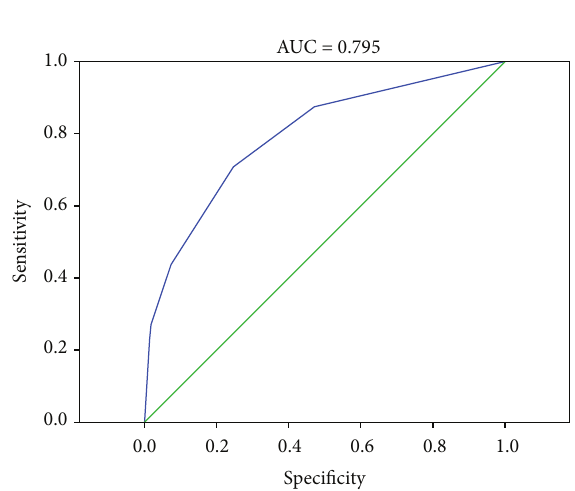
Figure 1: Receiver operating characteristics curve for CHADS 2 in prediction of MACEs in Cushing’s syndrome